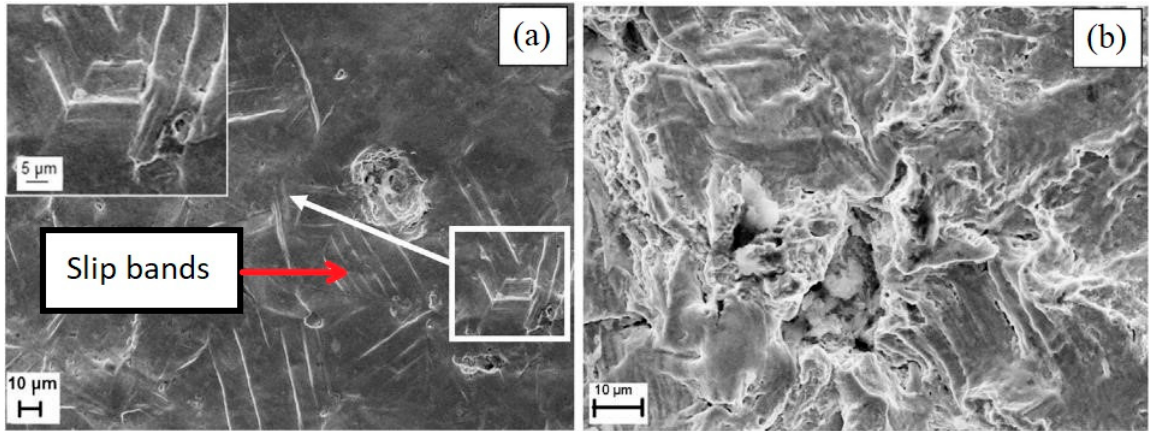
Figure 4. Degradation of 316L steel at low cavitation intensity ( p 1 = 600 kPa): ( a ) Damage in the slightly eroded area; ( b ) Damage in the severely eroded area [17] (Reprinted from “Effect of cavitation intensity on degradation of X6CrNiTi18-10 stainless steel” by A.K. Krella, A. Krupa, Wear, Volumes 408–409, 2018, Pages 180-189, ISSN 0043-1648, Copyright under license no. 5057500490519 (2021), with permission from Elsevier).